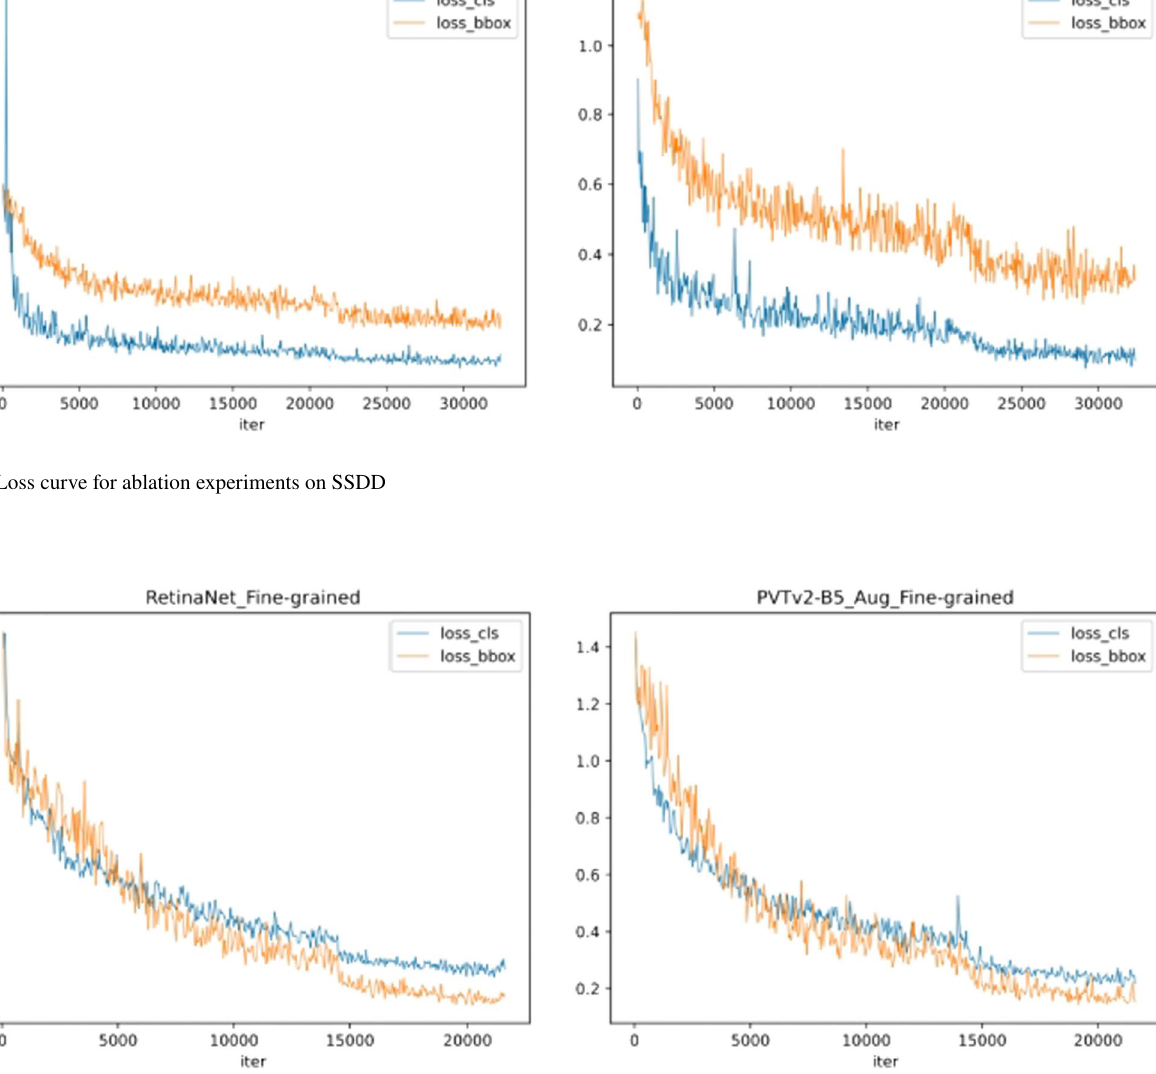
Fig. 7 Loss curve for fine-grained classification experiments on HRSC2016